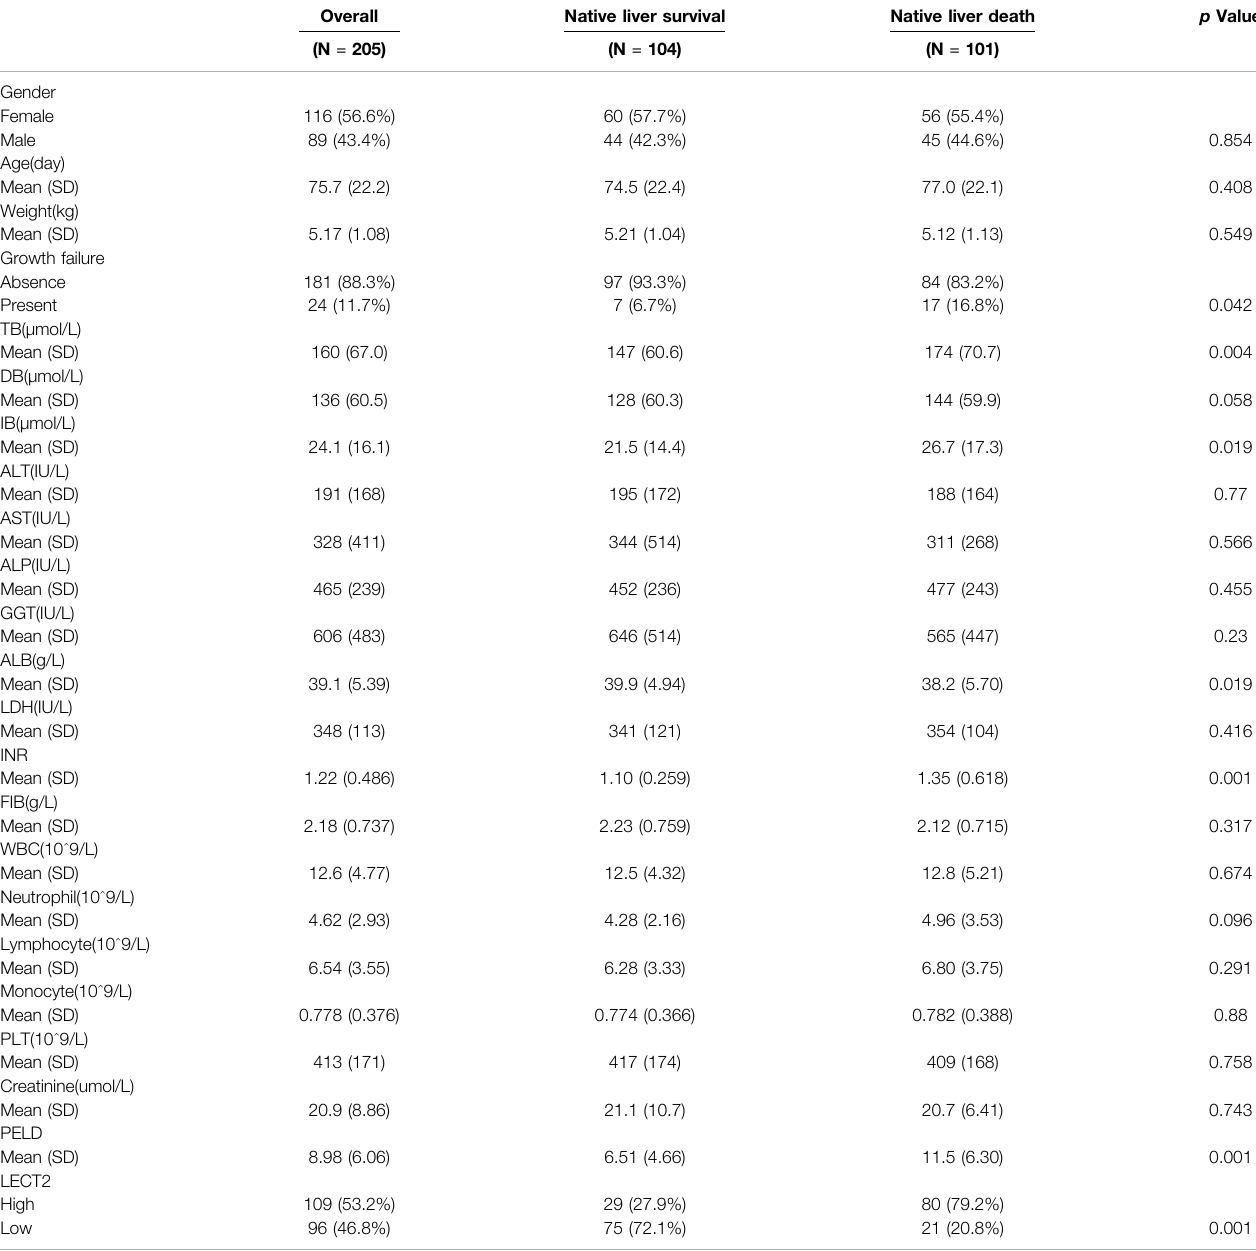
TABLE 1 | Clinical information of biliary atresia patients.